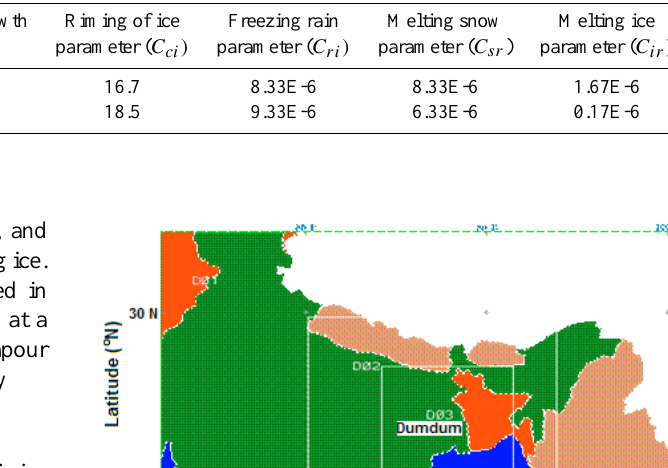
Table 1. Changes of controlling parameters in different processes in Schultz microphysics scheme.